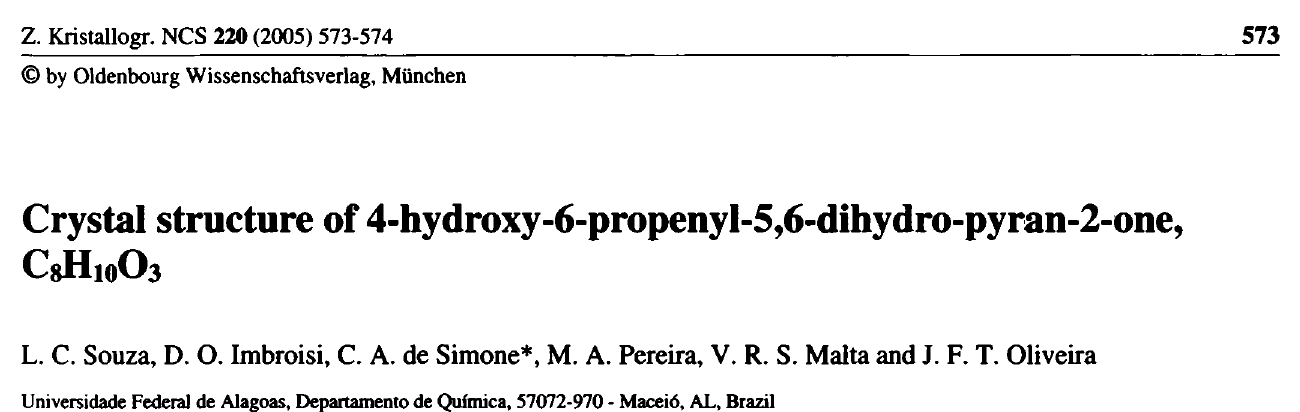
Table 1. Data collection and handling.